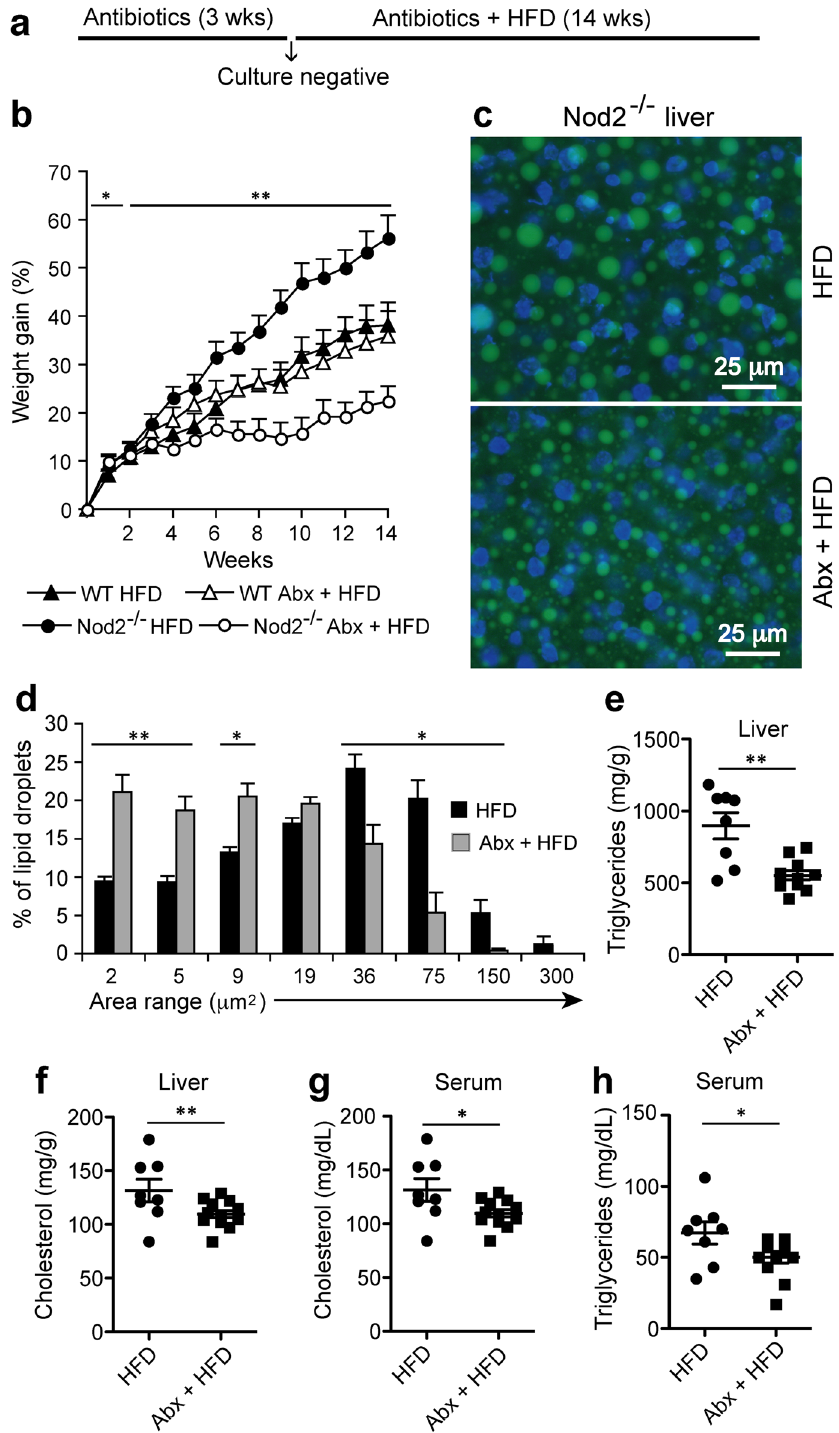
Figure 6. Antibiotic treatment prevents the development of obesity, steatosis, and metabolic dysfunction in Nod2 − / − mice on HFD. ( a ) Nod2 − / − and WT mice were treated with Abx to deplete their intestinal microbiota. Control mice were not treated with antibiotics. Three weeks after the start of Abx all mice were placed on HFD and monitored for weight gain, histopathology, and metabolites. ( b ) Percent gain in weight compared to week 0 of HFD. ( c , d ) After 14 weeks of HFD, mice were analyzed for liver histopathology in BODIPY and DAPI stained sections and ( d ) percent frequency distribution of LD area ( µ m 2 ) for ~4,000 LDs/group. ( e – h ) After 14 weeks of HFD, ( e ) liver triglycerides, ( f ) liver cholesterol, ( g ) serum cholesterol, and ( h ) serum triglycerides were measured. ( b , d ) Results are means ± SEM, ( C ) representative images, and ( e – h ) individual data of 6–10 mice/ group. * P ≤ 0.05 and ** P ≤ 0.001, Nod2 − / − Abx + HFD versus Nod2 − / −